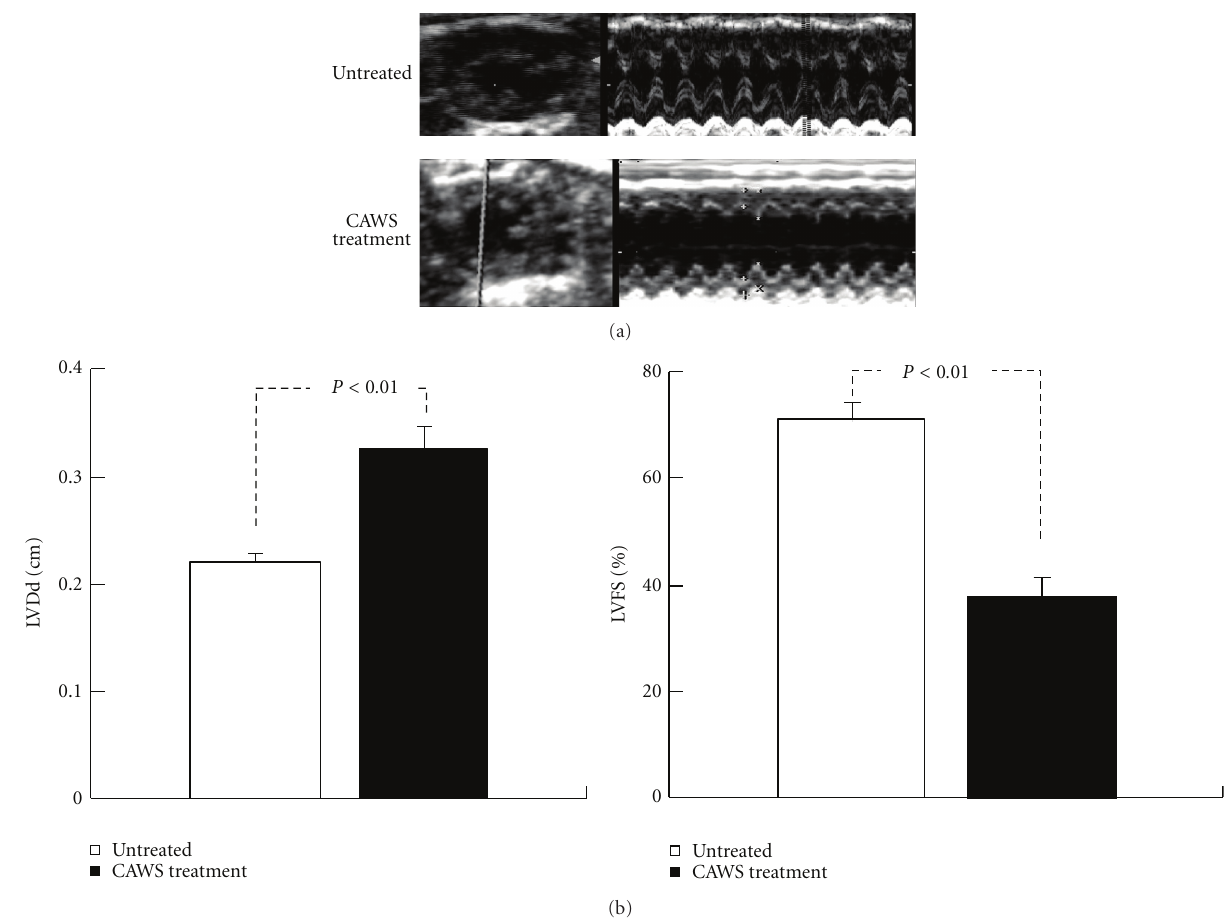
Figure 6: Comparison of the cardiac function measured by echocardiography in untreated and CAWS treatment DBA/2 mice. CAWS treatment DBA/2 mice developed left ventricular dilution and dysfunction between six and seven week after CAWS administration (a). Echocardiography revealed a di ff use, severe reduction of contractility in the left ventricle after CAWS treatment. Left ventricular fractional shortening (LVFS) decreased from 71% to 38% ( P < 0 . 01), and dilation of the left ventricular diastolic dimension (LVDd) was observed from 2.21 mm to 3.26 mm ( P < 0 . 01) (b); n = 10 (untreated) and n = 6 (CAWS treatment).